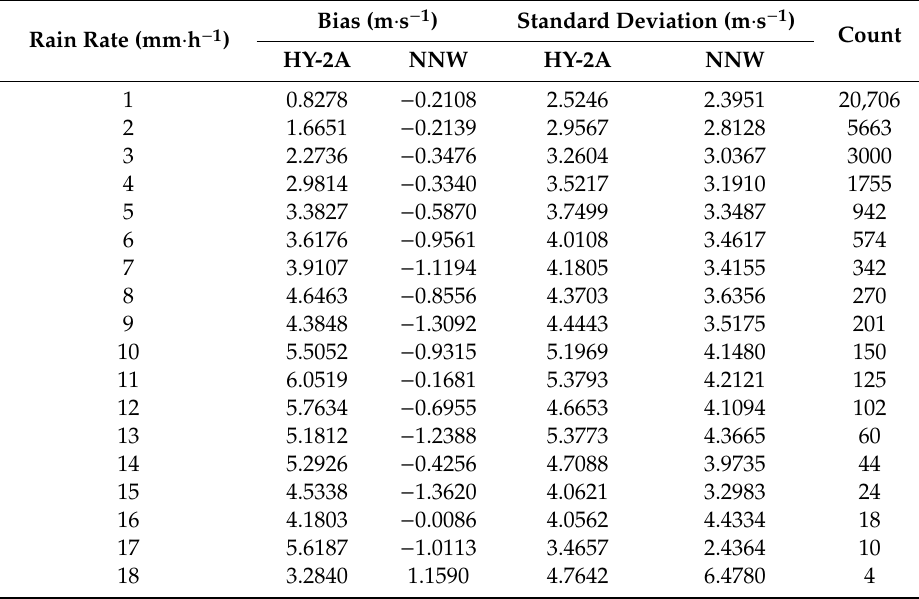
Table 5. The errors of HY-2A wind speed and NNW wind speed with ECMWF wind